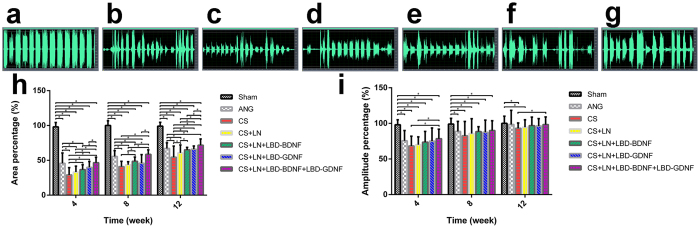
Vocalisation spectras, spectral area and amplitude percentages of different groups were shown.Vocalisation spectras were shown of the Sham (a), ANG (b), CS (c), CS+LN (d), CS+LN+LBD-BDNF (e), CS+LN+LBD-GDNF (f) and CS+LN+LBD-BDNF+LBD-GDNF (g) groups at 12 weeks after surgery. The Sham group exhibits a high amplitude with wide and continuous waveforms. (h) Spectral area percentages of different groups. The spectral area, calculated as a percentage of that in the Sham group increased over time. The spectral area percentages measured at 12 weeks after surgery were 100.0 ± 7.0%, 67.0 ± 8.2%, 54.4 ± 16.0%, 60.7 ± 11.3%, 65.1 ± 3.5%, 65.9 ± 4.6%, and 71.7 ± 9.0% of all the above group orders, respectively. The spectral area percentage of the CS+LN+LBD-BDNF group was much higher than that of the CS group at week 4, 8 and 12 week (P < 0.05), but much lower than that of CS+LN+LBD-BDNF+LBD-GDNF and Sham groups (P < 0.05). At week 12, there was no significant difference between the CS+LN+LBD-BDNF group and CS+LN+LBD-GDNF or ANG group (P > 0.05). The spectral area percentage of the CS+LN+LBD-BDNF+LBD-GDNF group showed no significant difference compared to that of the ANG group at 4 and 8 weeks (P > 0.05), while the ANG group showed significant lower compared to the CS+LN+LBD-BDNF+LBD-GDNF group at 12 weeks after surgery (P < 0.05). (i) The amplitude percentages of different groups were shown. The spectral amplitude, calculated as a percentage of that in the Sham group increased with time. The amplitude percentages of the ANG, CS+LN+LBD-BDNF, CS+LN+LBD-GDNF and CS+LN+LBD-BDNF+LBD-GDNF groups were not significantly different from that of the Sham group at 12 weeks after surgery (P > 0.05). From week 4 to week 12, the amplitude percentage of the CS+LN+LBD-BDNF+LBD-GDNF group was not significantly different from that of the CS+LN+LBD-BDNF or CS+LN+LBD-GDNF group (P > 0.05). n = 30. *P < 0.05.